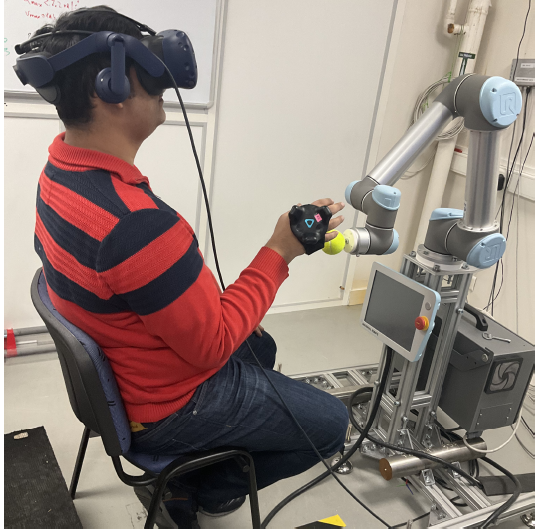
Figure 8. The user performing the experimental task in unity without motion of the